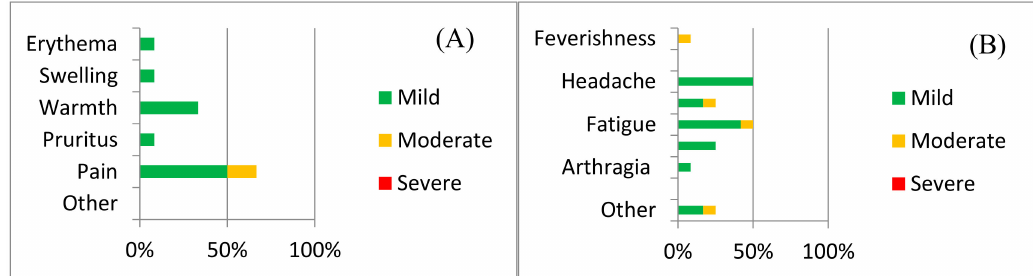
Figure 2. Safety data for ChAdOx2 HAV: The frequency of adverse reactions following vaccination with ChAdOx2 HAV is shown, with severity indicated by shading. ( A ) Local adverse reactions and ( B ) systemic adverse reactions. Data represent adverse reactions from all 12 volunteers across all three